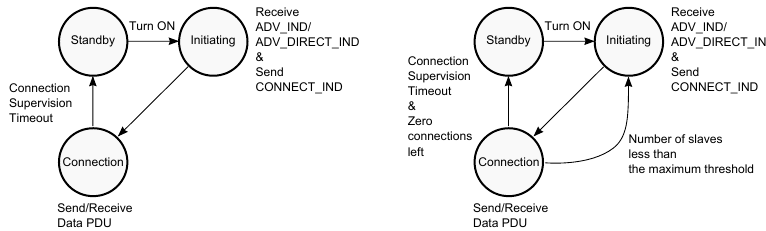
Figure 8. State diagrams of the master device in one slave (on the left) and multiple slaves (on the right)